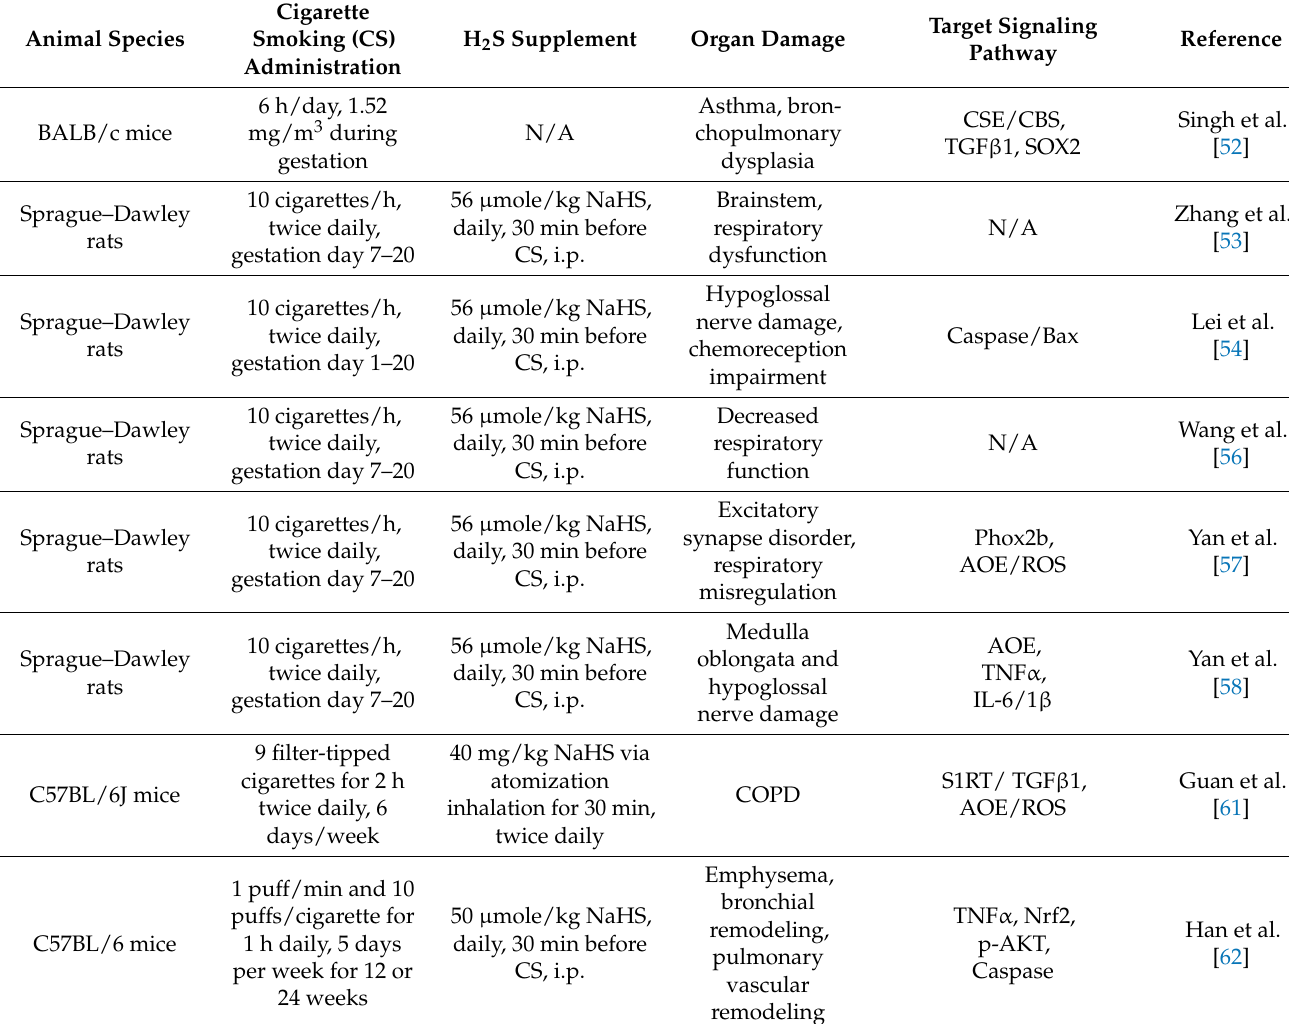
Table 1. Animal models used for analyzing H 2 S signaling and cigarette smoking-induced